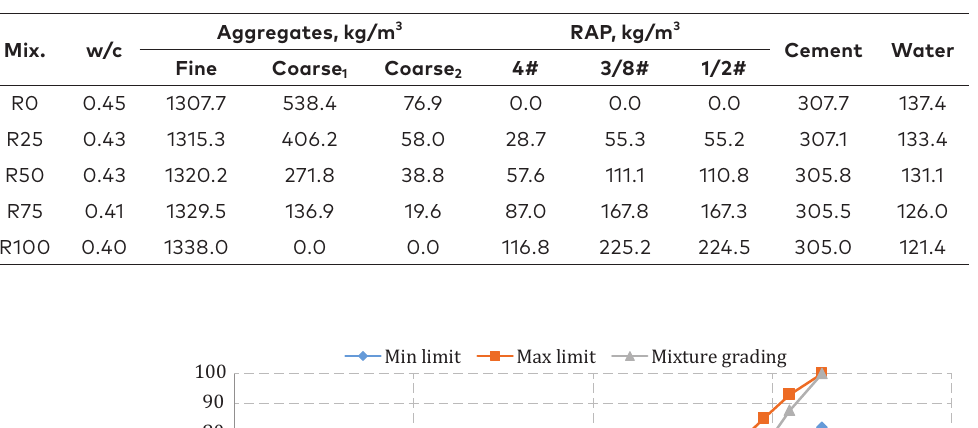
Table 3. Mixing proportions for all mixtures